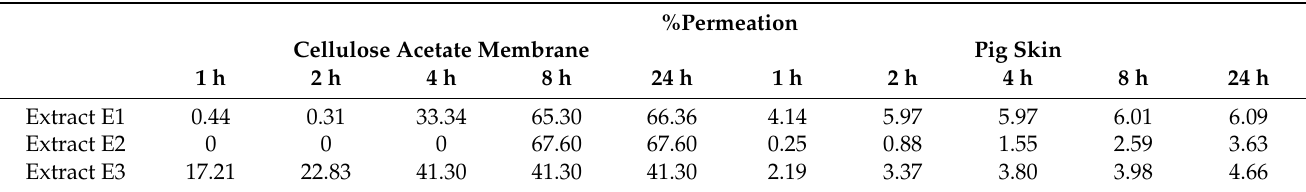
Table 5. Transdermal permeation values (%) through cellulose acetate membrane and pig skin for E1, E2, and E3 extracts over 24